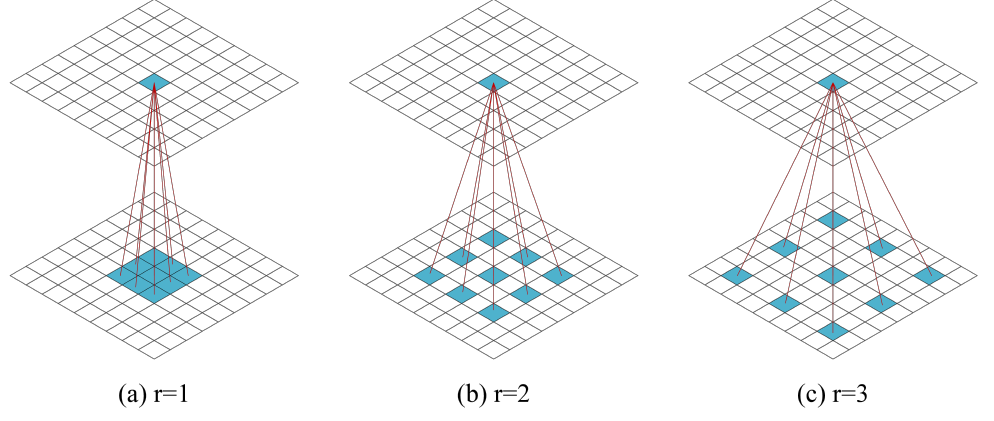
Figure 3. Dilated convolution receptive fields with different